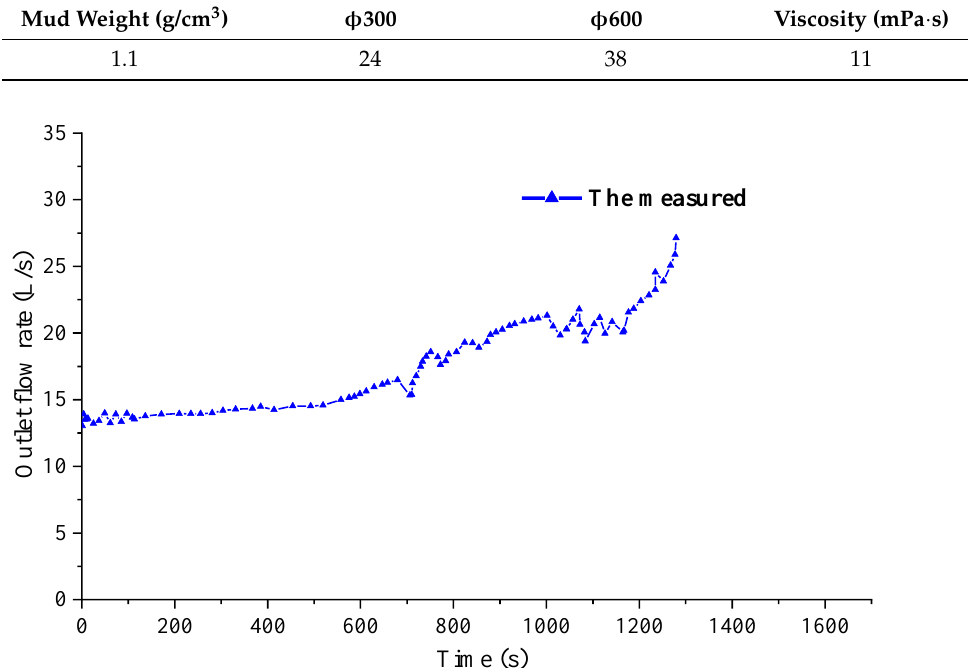
Figure 10. The simulated outlet flow time series for well L.